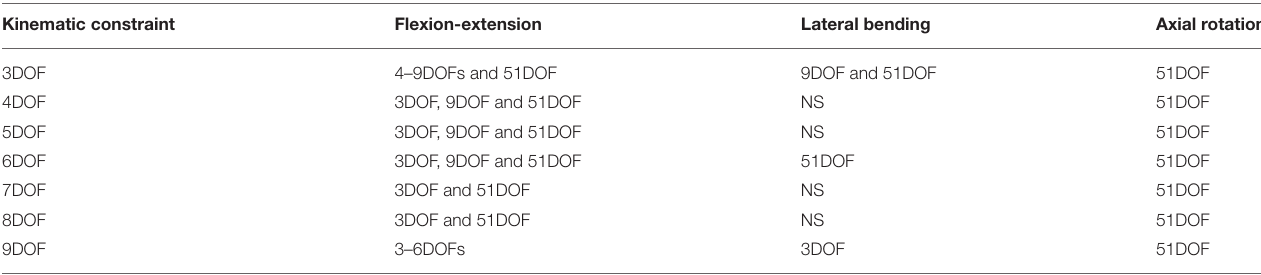
TABLE 5 | Pairwise comparisons (Tukey’s HSD) of kinematic constraints for lag-one autocorrelation coefficients of angular motions for each primary direction of tasks (FE, LB, and AR). Kinematic constraint